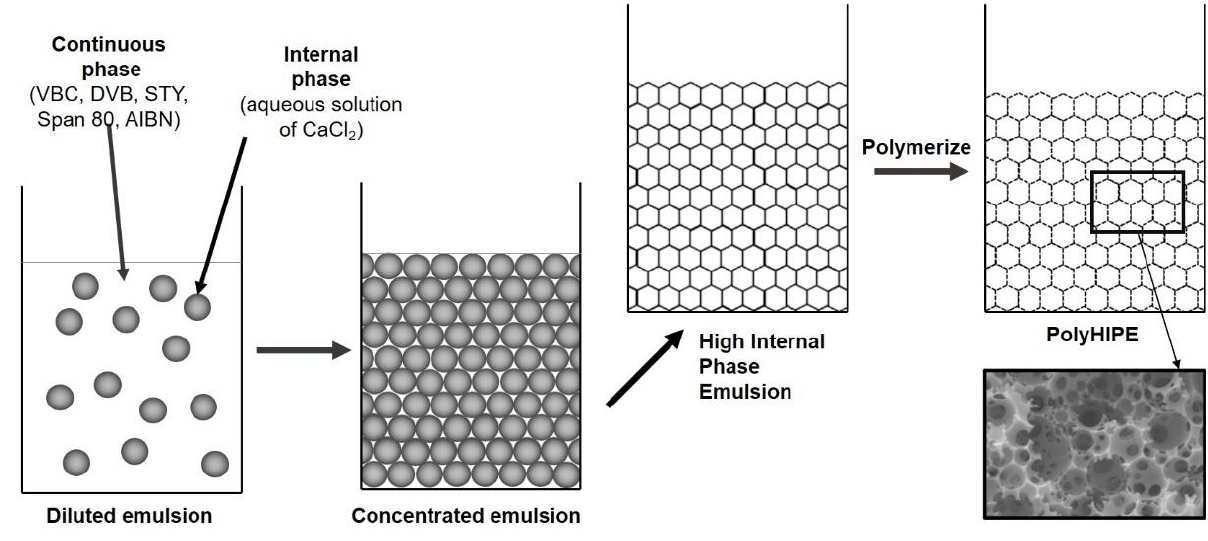
Figure 1. PolyHIPE preparation .